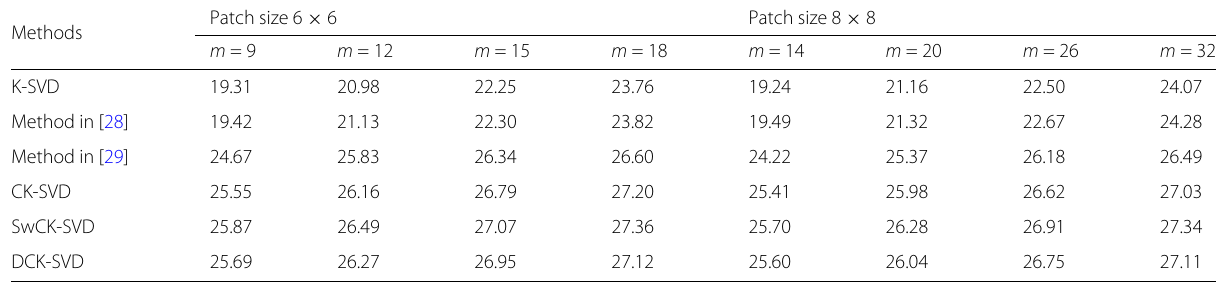
Table 5 Comparison of PSNR (dB) of reconstructed image “Horse” using the DCT basis for initialization Methods